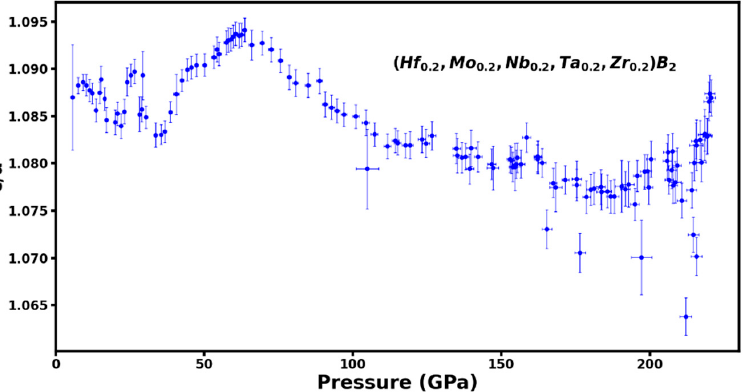
Figure 5. The axial ( c / a ) ratio for the hexagonal AlB 2 -type phase of (Hf 0.2 , Mo 0.2 , Nb 0.2 , Ta 0.2 , Zr 0.2 )B 2 as a function of pressure to 220 GPa. The axial ( c / a ) ratio shows only slight variation of 2–3% over a large pressure range indicating lack of strong anisotropic compression effects.